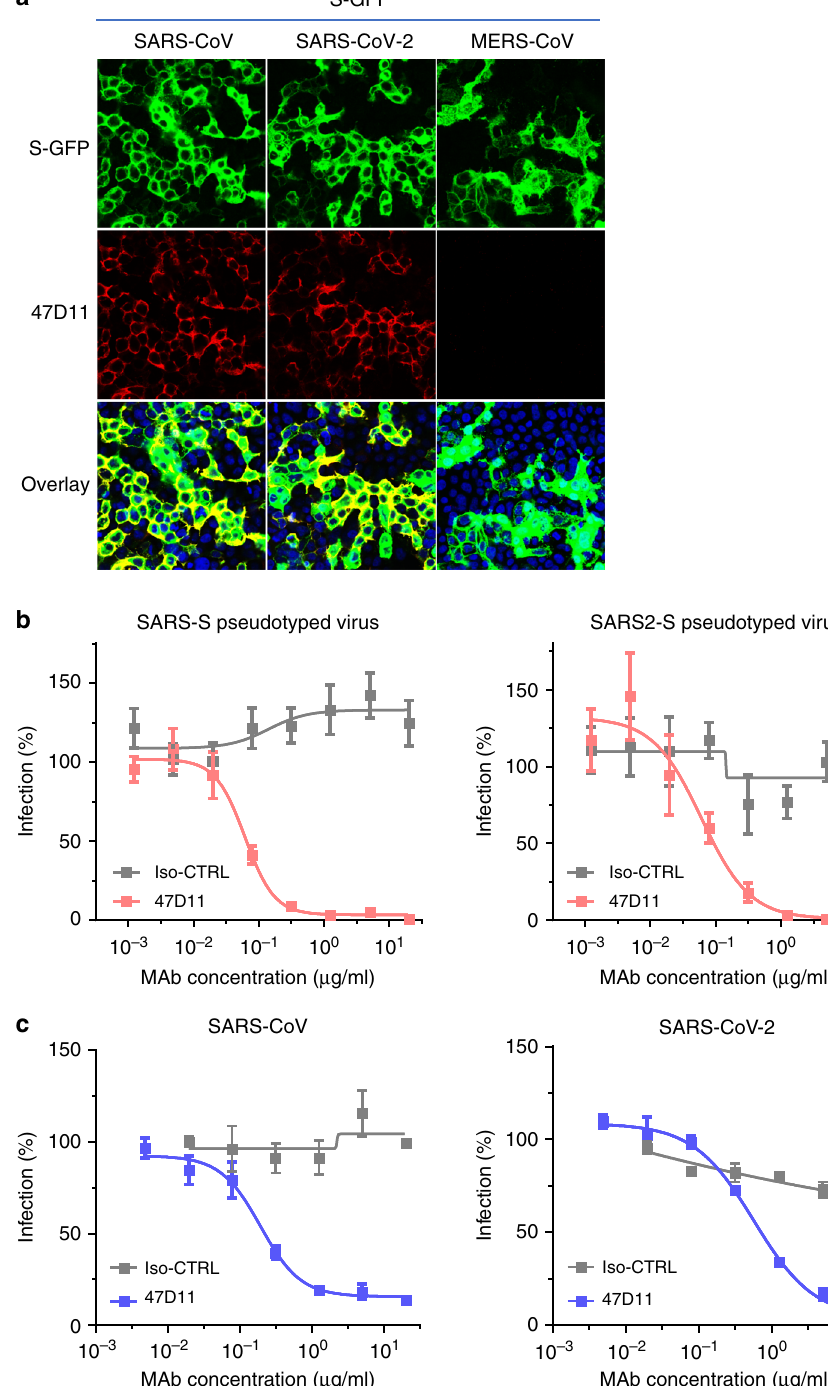
Fig. 1 47D11 neutralizes SARS-CoV and SARS-CoV-2. a Binding of 47D11 to HEK-293T cells expressing GFP-tagged spike proteins of SARS-CoV and SARS-CoV-2 detected by immuno fl uorescence assay. The human mAb 7.7G6 targeting the MERS-CoV S1 B spike domain was taken along as a negative control, cell nuclei in the overlay images are visualized with DAPI. b Antibody-mediated neutralization of infection of luciferase-encoding VSV particles pseudotyped with spike proteins of SARS-CoV and SARS-CoV-2. Pseudotyped VSV particles pre-incubated with antibodies at indicated concentrations (see Methods) were used to infect VeroE6 cells and luciferase activities in cell lysates were determined at 24 h post transduction to calculate infection (%) relative to non-antibody-treated controls. The average ± SD from at least three independent experiments with technical triplicates is shown. Iso-CTRL: an anti-Strep-tag human monoclonal antibody 11 was used as an antibody isotype control. c Antibody-mediated neutralization of SARS-CoV and SARS-CoV-2 infection on VeroE6 cells. The experiment was performed with triplicate samples, the average ± SD is shown. Source data are provided as a Source Data fi